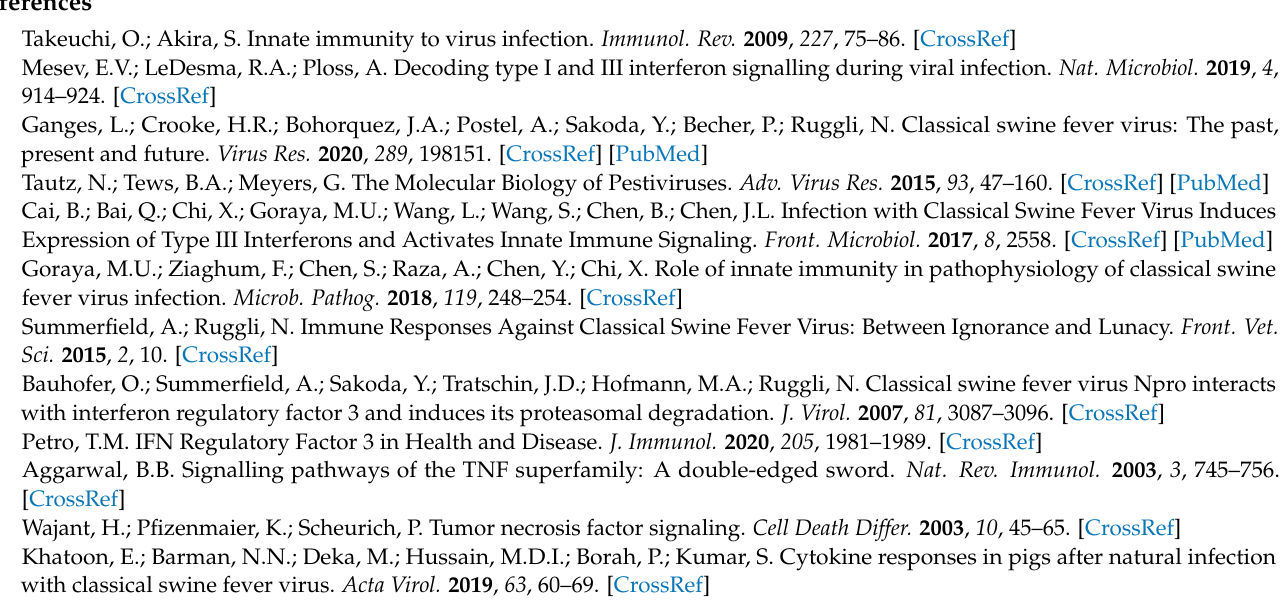
Figure S2: Verification of CSFV infection of PEDSV.15, IRF1-KO#2 and IRF3-KO#4 cells from the experiments in Figure